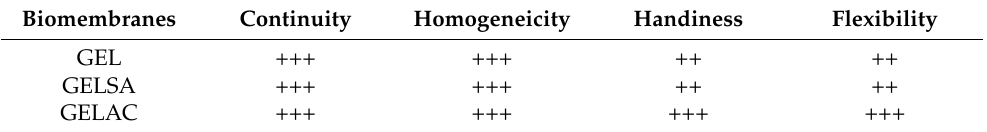
Table 2. Main morphological characteristics observed in GEL, GELSA, and GELAC biomembranes.